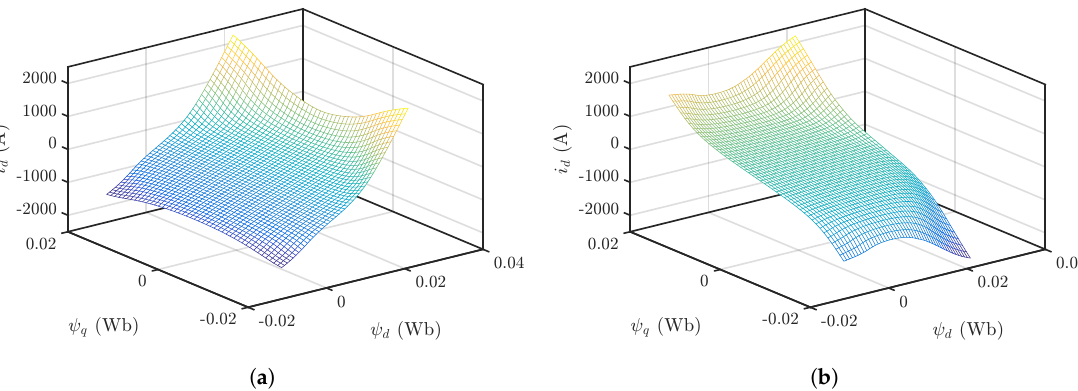
Figure 7. Inverse flux map for ( a ) d -axis and ( b ) q -axis current.